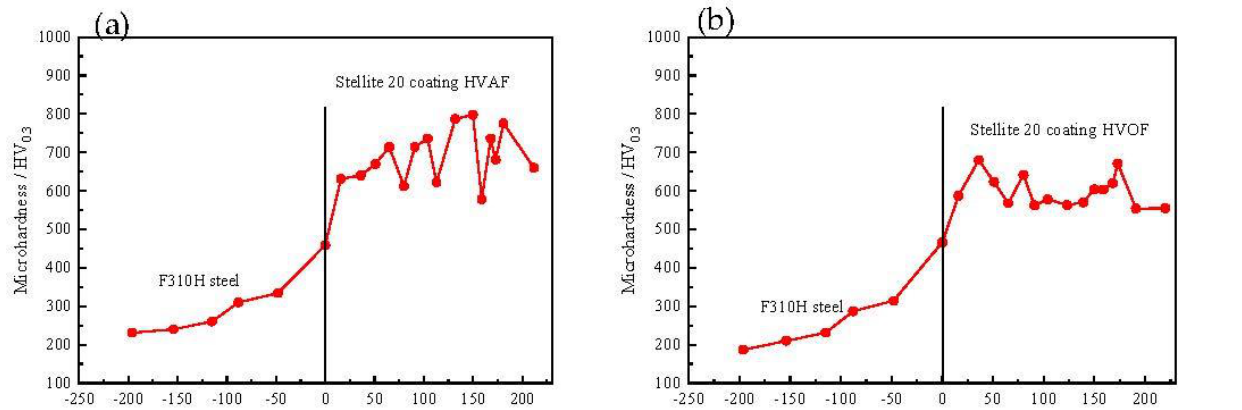
Figure 6. Microhardness profile of Stellite 20 coatings deposited by HVAF ( a ) and HVOF ( b ). In order to address the issue of large dispersion in determined microhardness values, which can be attributed to the non-uniformity of composition and microstructure of ther- mal spray coatings, as well as errors in sample preparation and measurement, this study employs the Weibull statistical method [25] to further characterize the relationship be- tween the microstructure and microhardness of supersonic sprayed coatings. The shape parameter (β) in equation (1) reflects the dispersion of coating hardness distribution, with a larger value indicating lower dispersion and higher stability of coating properties, and vice